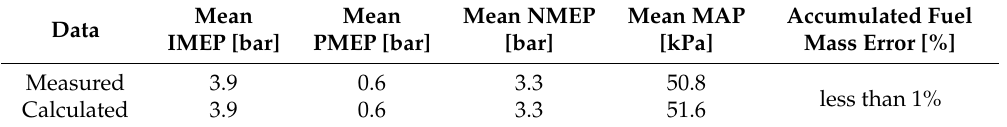
Table 2. Comparison between measured and calculated data of vehicle 3 in FTP-75.